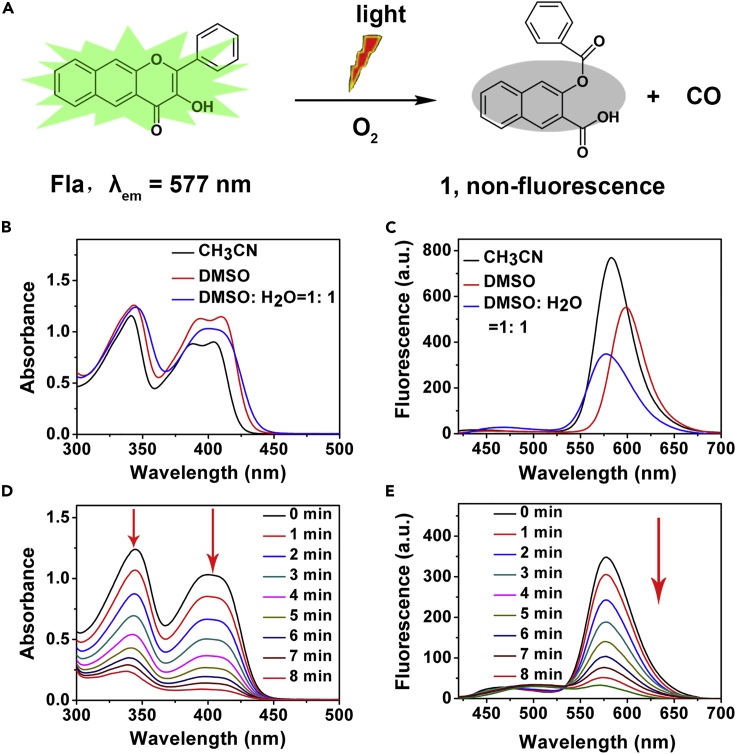
Photo-Induced CO Release Reaction of Fla(A) Schematic illustration of photo-induced CO release reaction of Fla.(B and C) (B) Absorption and (C) Emission spectra of Fla (0.1 mM) in various solvents (λex = 409 nm).(D and E) (D) Absorption and (E) Emission spectra of Fla (0.1 mM) with the light illumination (λ = 410 nm; power = 15 mW/cm2) under air for 8 min at 37°C in DMSO: H2O (1:1, v/v).